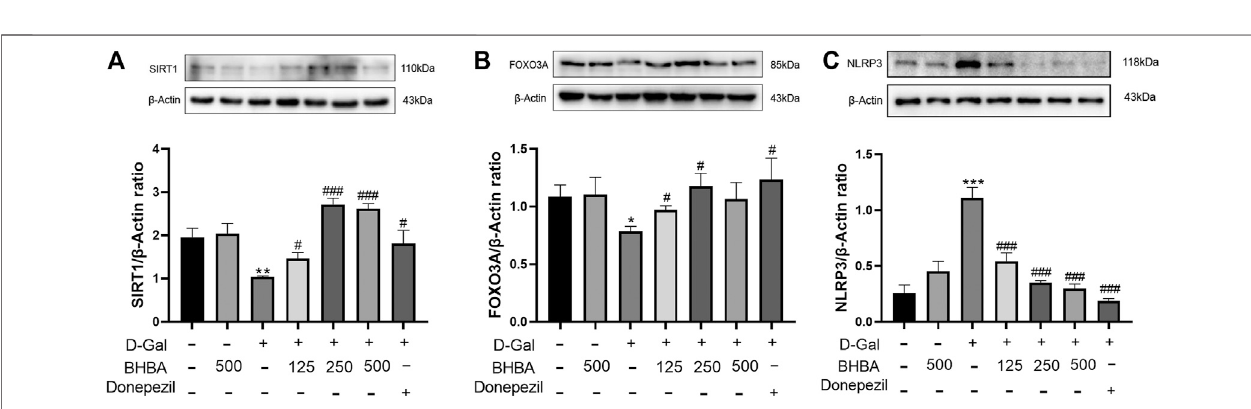
FIGURE 4 | Effects of BHBA on hippocampal SIRT1, FOXO3A, and NLRP3 expression in D-gal-induced mice. (A) Protein expression of SIRT1. (B) Protein expression ofFOXO3A. (C) Proteinexpression ofNLRP3.D-gal: 180 mg/kg; BHBA:125, 250,and 500 mg/kg, respectively; donepezil:3 mg/kg, n (cid:1) 3.Comparedwith the control group, * p < 0.05, ** p < 0.01, *** p < 0.001; compared with the D-gal group, # p < 0.05, ### p < 0.001.